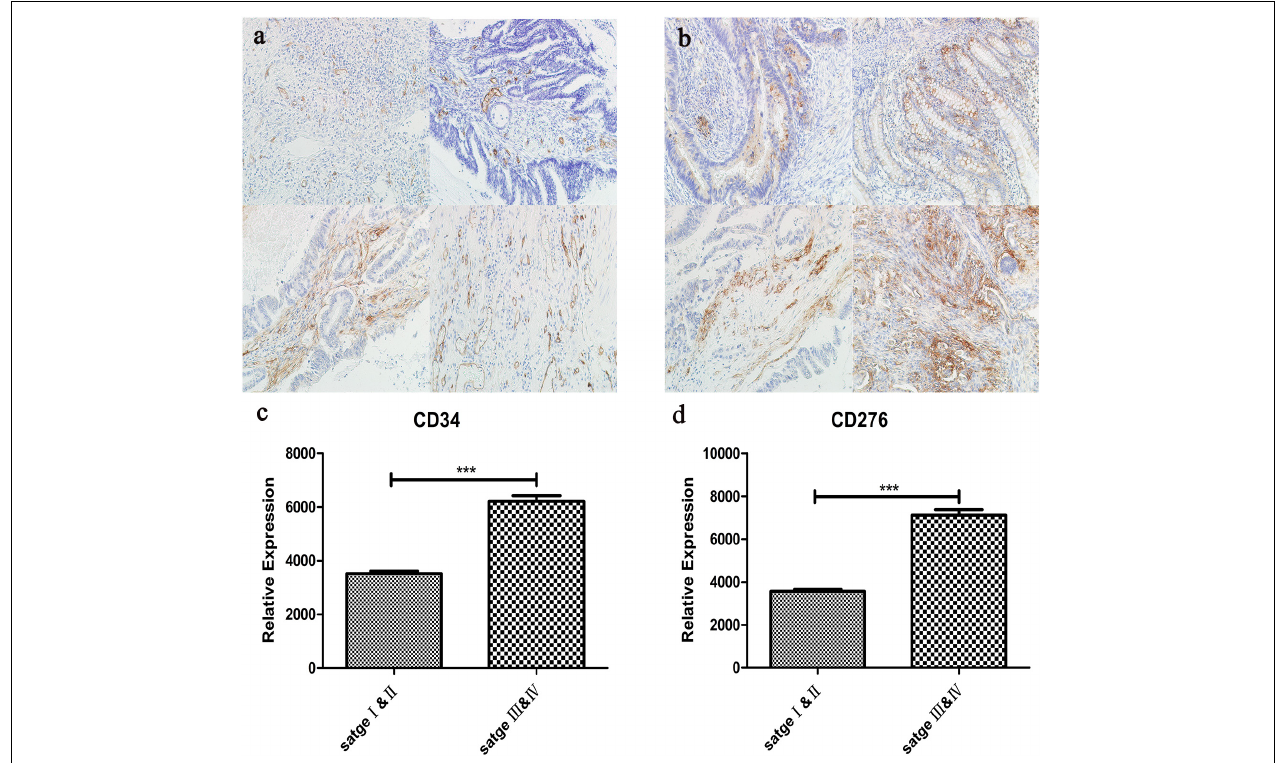
FIGURE 7 | (a) The expression of CD34 in CRC tissues was detected by immunohistochemistry, upper left:stage I, upper right:stage II, left lower:stage III, lower right:stage IV. (b) The expression of CD276 in CRC tissues was detected by immunohistochemistry, upper left:stage I, upper right:stage II, left lower:stage III, lower right:stage IV. (c) Compared with stage I and II, CD34 expression was significantly up-regulated in stage III and IV (*** P < 0.001). (d) Compared with stage I and II, CD276 expression was significantly up-regulated in stage III and IV (*** P <